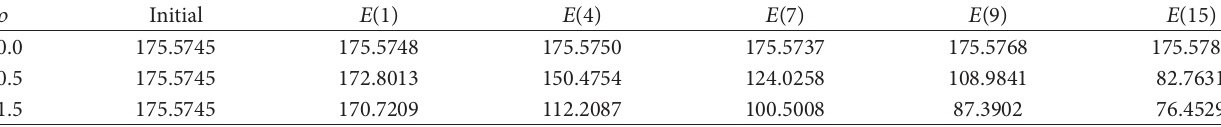
Figure 2: Absolute error of the solution of the PC-DFFD scheme in 𝑡 = 4, 10, 20, 25 for test problems (66)–(68). Table 2: The energy 𝐸(𝑡) of the superposition of two orthogonal line